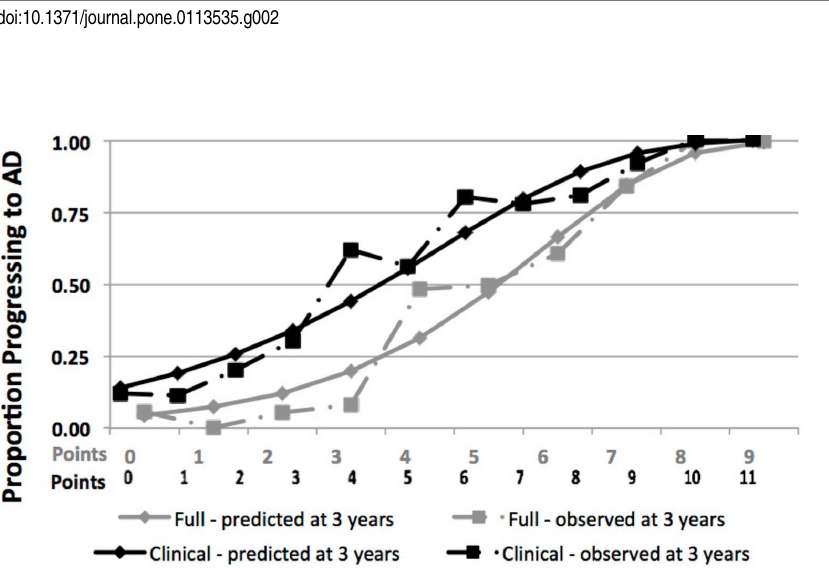
Fig. 3. Comparison of the Full and Brief Clinical AD Prediction Indexes. The predicted (solid lines) and observed (dashed lines) are shown as a function of risk score values based on the previously published full index (light grey lines) and brief clinical index (dark grey lines). Prognostic accuracy was significantly higher for the full index (optimism corrected Harrell’s c, 0.74) than the brief clinical index (0.71). However, the plot shows good concordance between observed and predicted risk for both